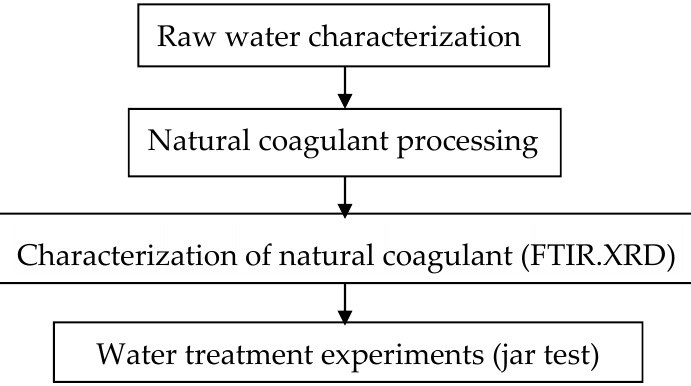
Figure 1. Flow chart of the experimental activities.